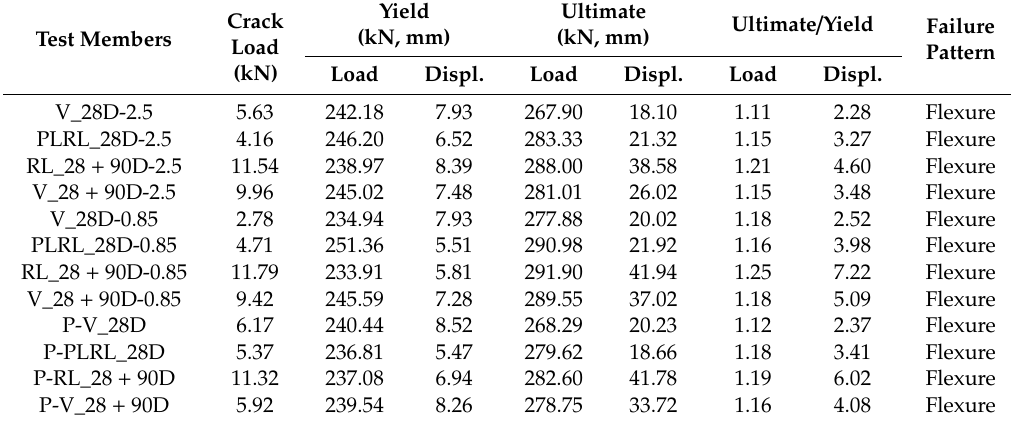
Table 8. Crack, yield and ultimate loads and failure patterns of test